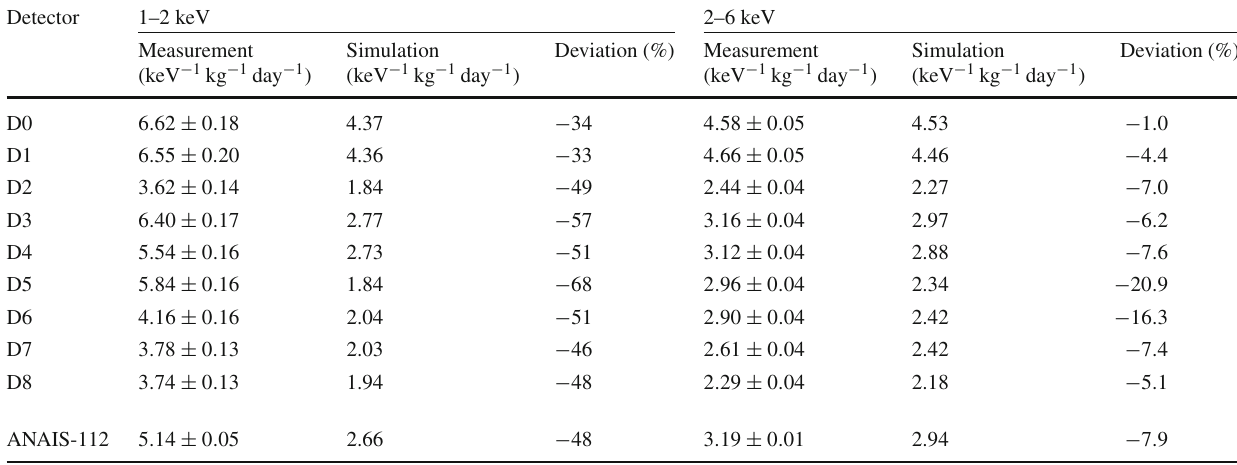
Table 9 Measured rates (after correction for efficiency of the filtering procedure) in the regions from 1 to 2 keV and from 2 to 6 keV for each ANAIS-112 detector and on average, from the 10% of unblinded data